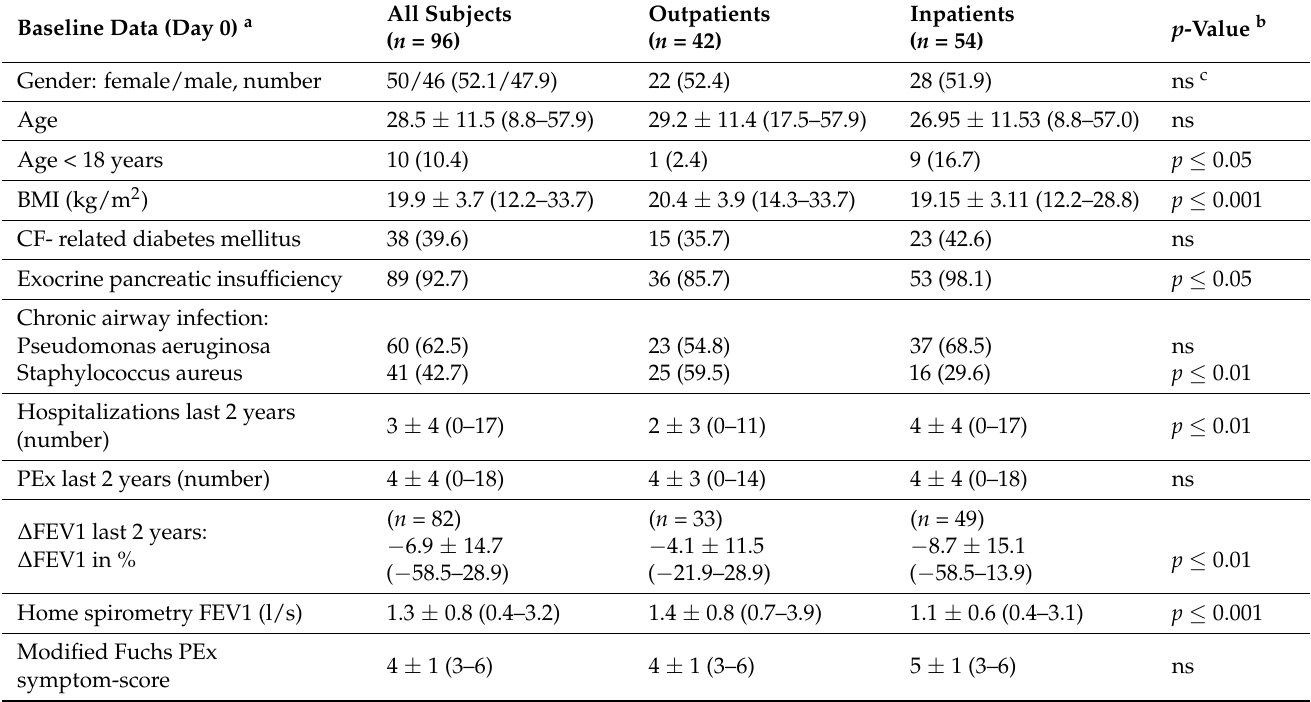
Table 1. Baseline Data (Day 0).